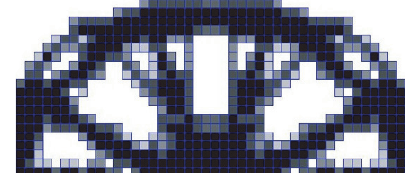
Fig. 8. Optimal solution by GA.